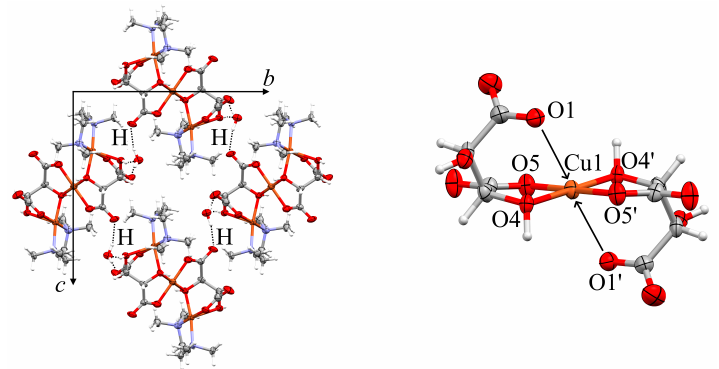
Figure 6. Left: Unit cell of 2b including intermolecular H bonds. Right: Excerpt of the crystal structure showing the square planar coordination around Cu1 and the far more distant (>3 Å) oxygen neighbors O1 and O1 (cid:48)